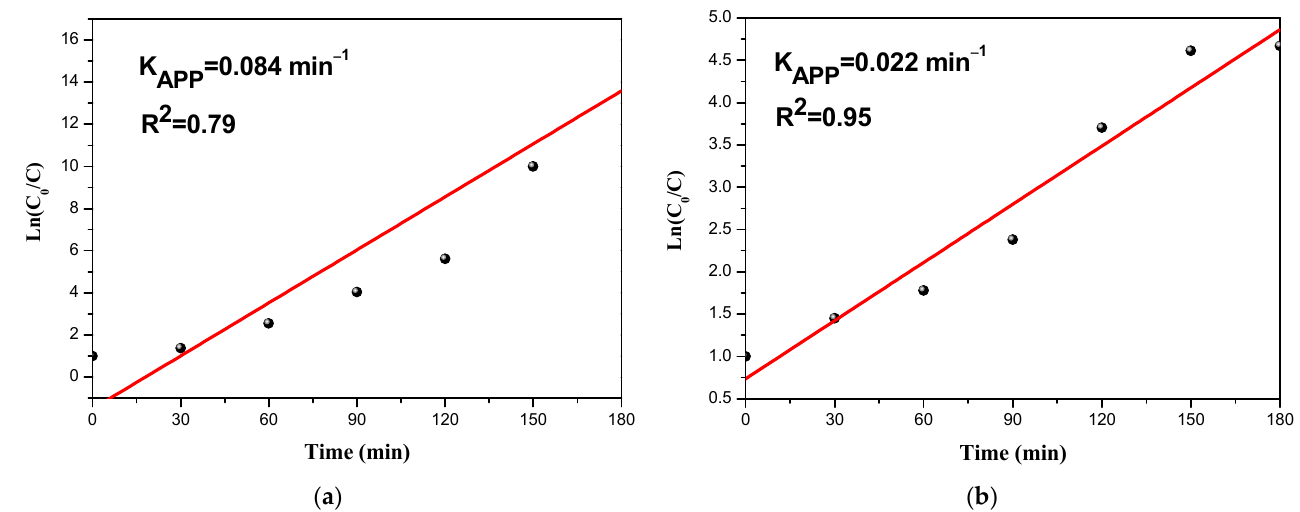
Figure 9. Pseudo-first-order kinetic plot ( a ) of the CFX degradation ( b ) of Cr(VI) reduction. The apparent rate constant was calculated to be 0.084 min − 1 and 0.022 min − 1 , respec- tively, for CFX, and Cr(VI). The rate constant for the organic pollutant degradation was found to be higher than that of inorganic compounds. This means that the degradation of organic pollutants was faster than the reduction of inorganic pollutants. Table 2 summarizes a list of bibliographical references with the use of sillenites for photocatalytic application to remove both organic and inorganic pollutants. Our catalyst has exhibited unusual photocatalytic activity in both degradation and reduction compared to other sillenites used in earlier studies. Table 2. Sillenites used for photocatalytic